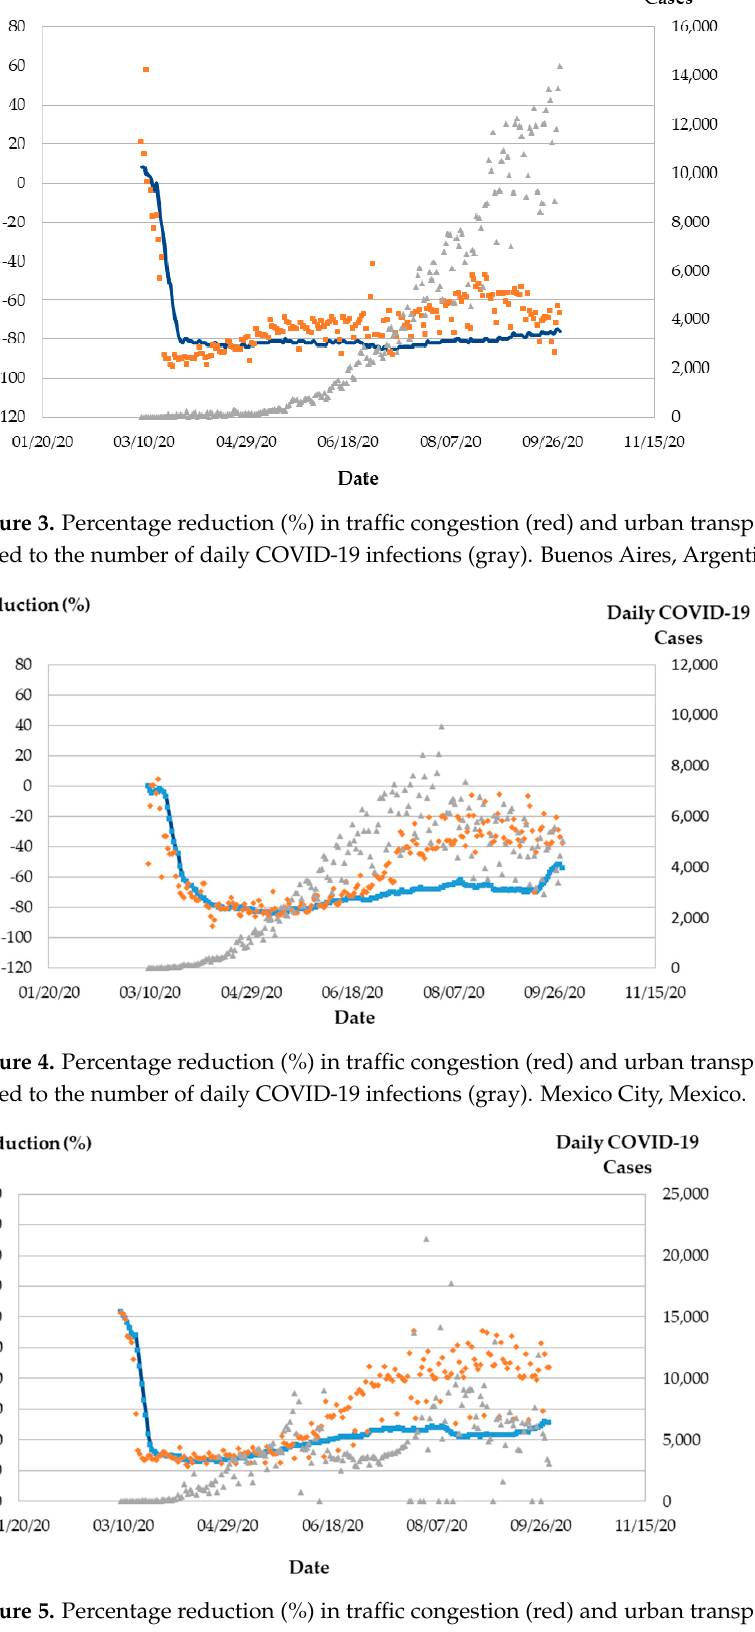
Figure 6. Percentage reduction (%) in traffic congestion (red) and urban transport use (blue), com- pared to the number of daily COVID-19 infections (gray). Lima, Perú.